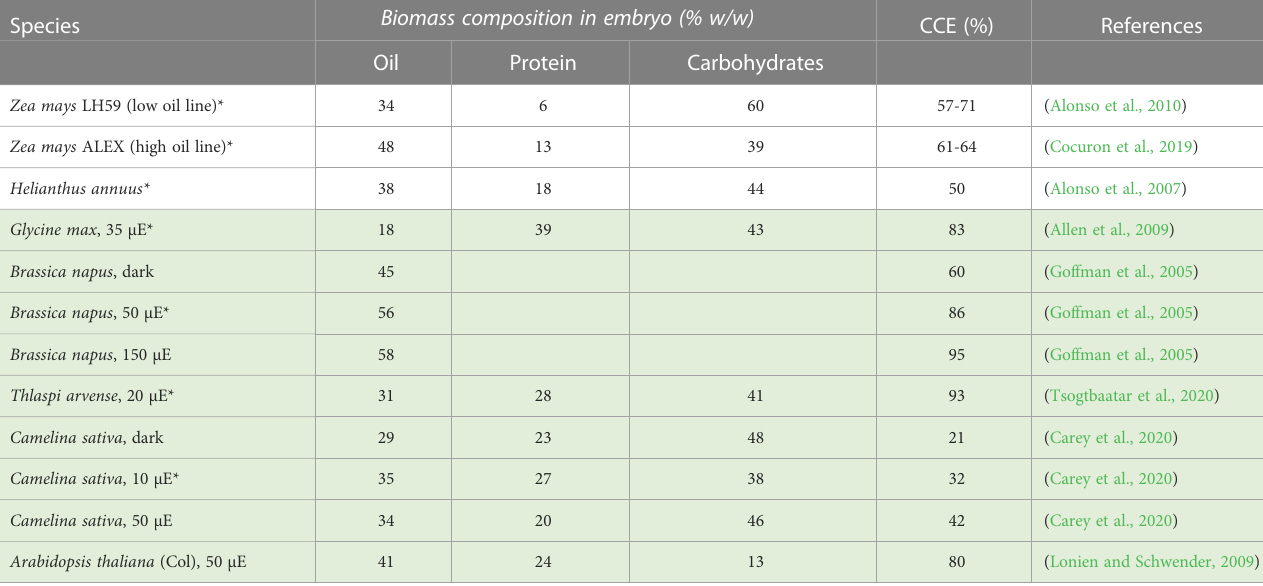
TABLE 1 Biomass composition and carbon conversion ef fi